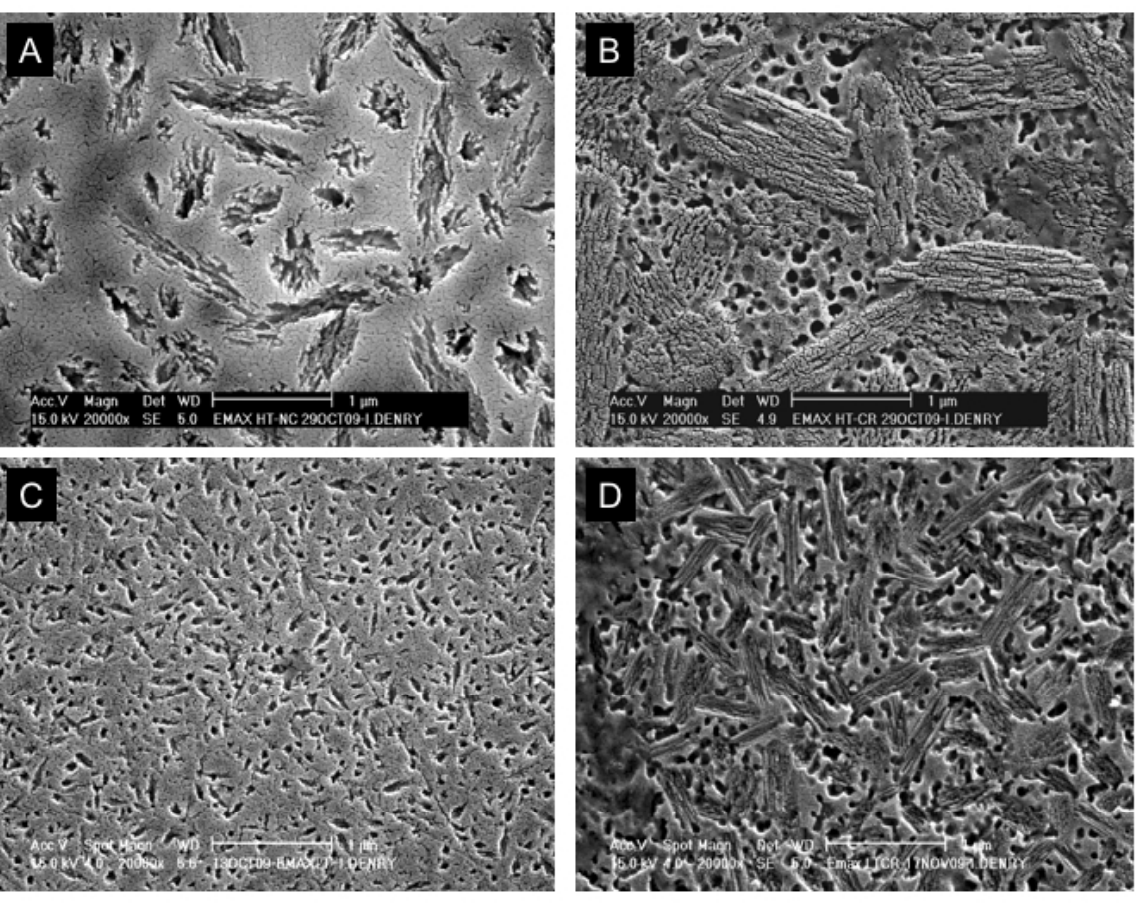
Figure 9. (a) Partially crystallized High Translucency (HT) lithium silicate machinable ceramic. (b) Fully crystallized HT lithium disilicate ceramic. (c) Partially crystallized Low Translucency (LT) lithium silicate machinable ceramic. (d) Fully crystallized LT